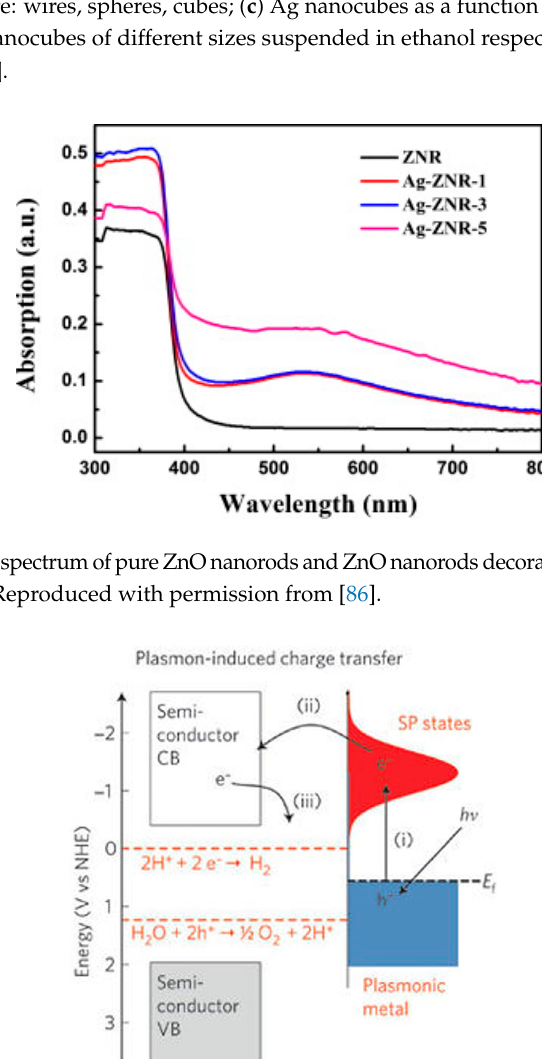
Figure 74. LSPR induced charge transfer with approximate energy level on the normal hydrogen electrode (NHE) scale. Dashed red lines refer to the water-splitting redox potentials. Reproduced with permission from [122].